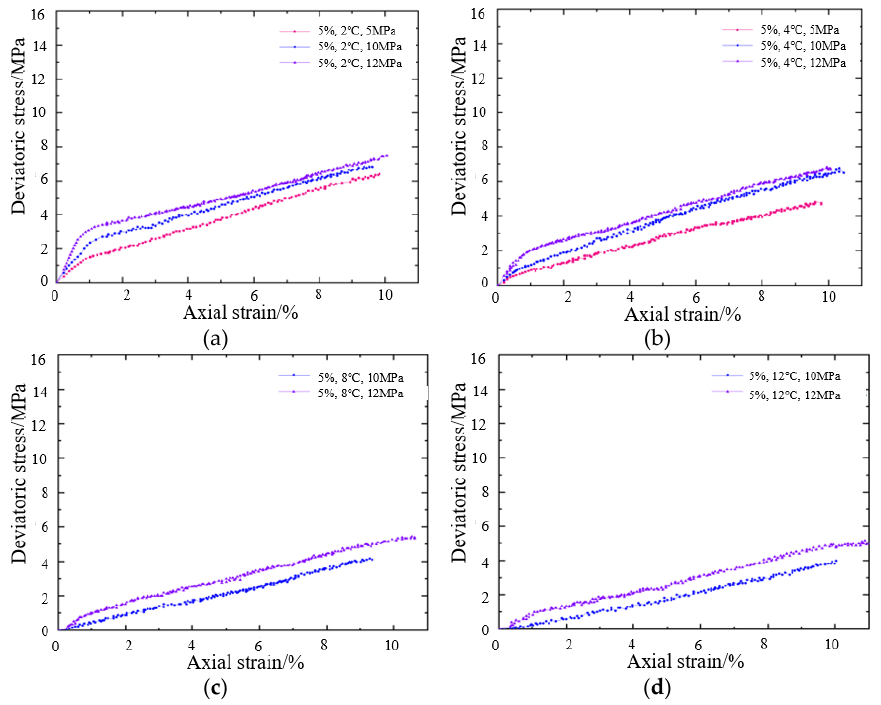
Figure 12. Core stress–strain curves at different temperatures (saturation 5%) ( a ) The test tempera- ture is 4 °C; ( b ) The test temperature is 4 °C; ( c ) The test temperature is 8 °C; ( d ) The test